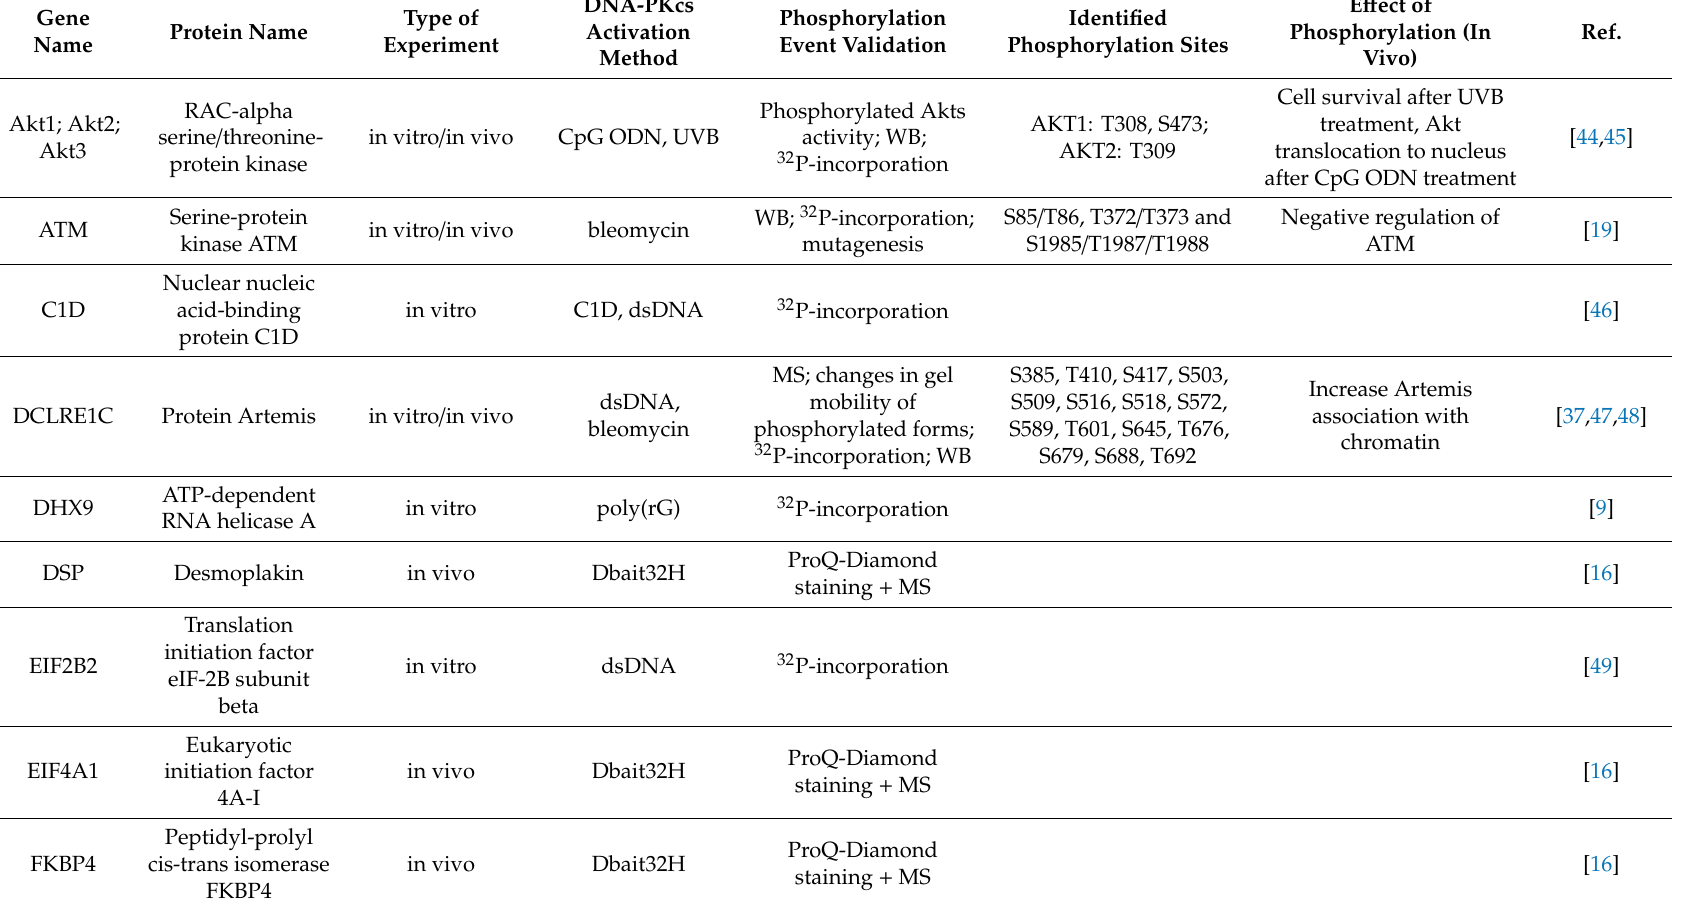
Table 1. DNA-PK targets and e ff ects of their